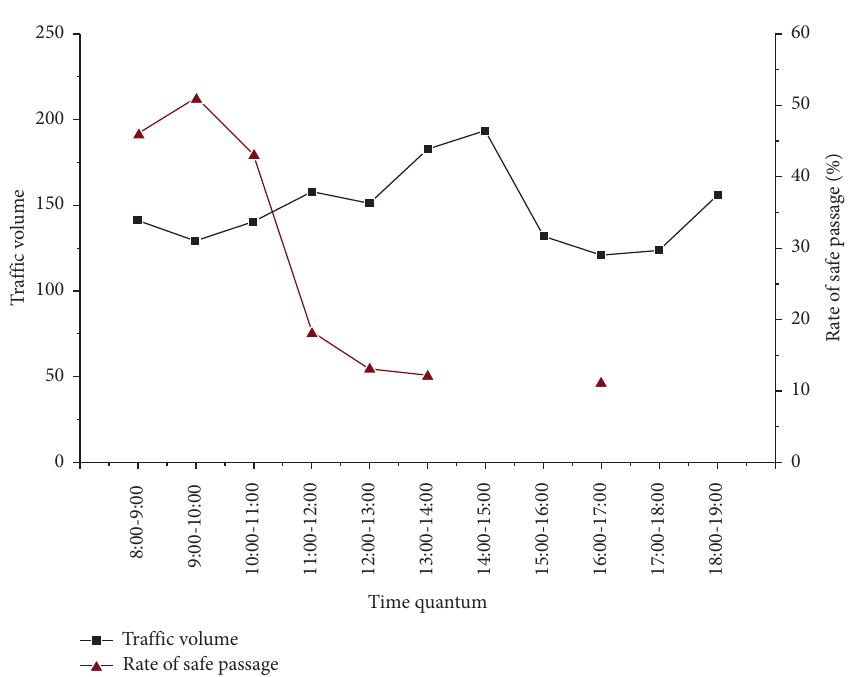
Figure 4: Hourly variation in traffic flow at K2998 and rate of safe passage of